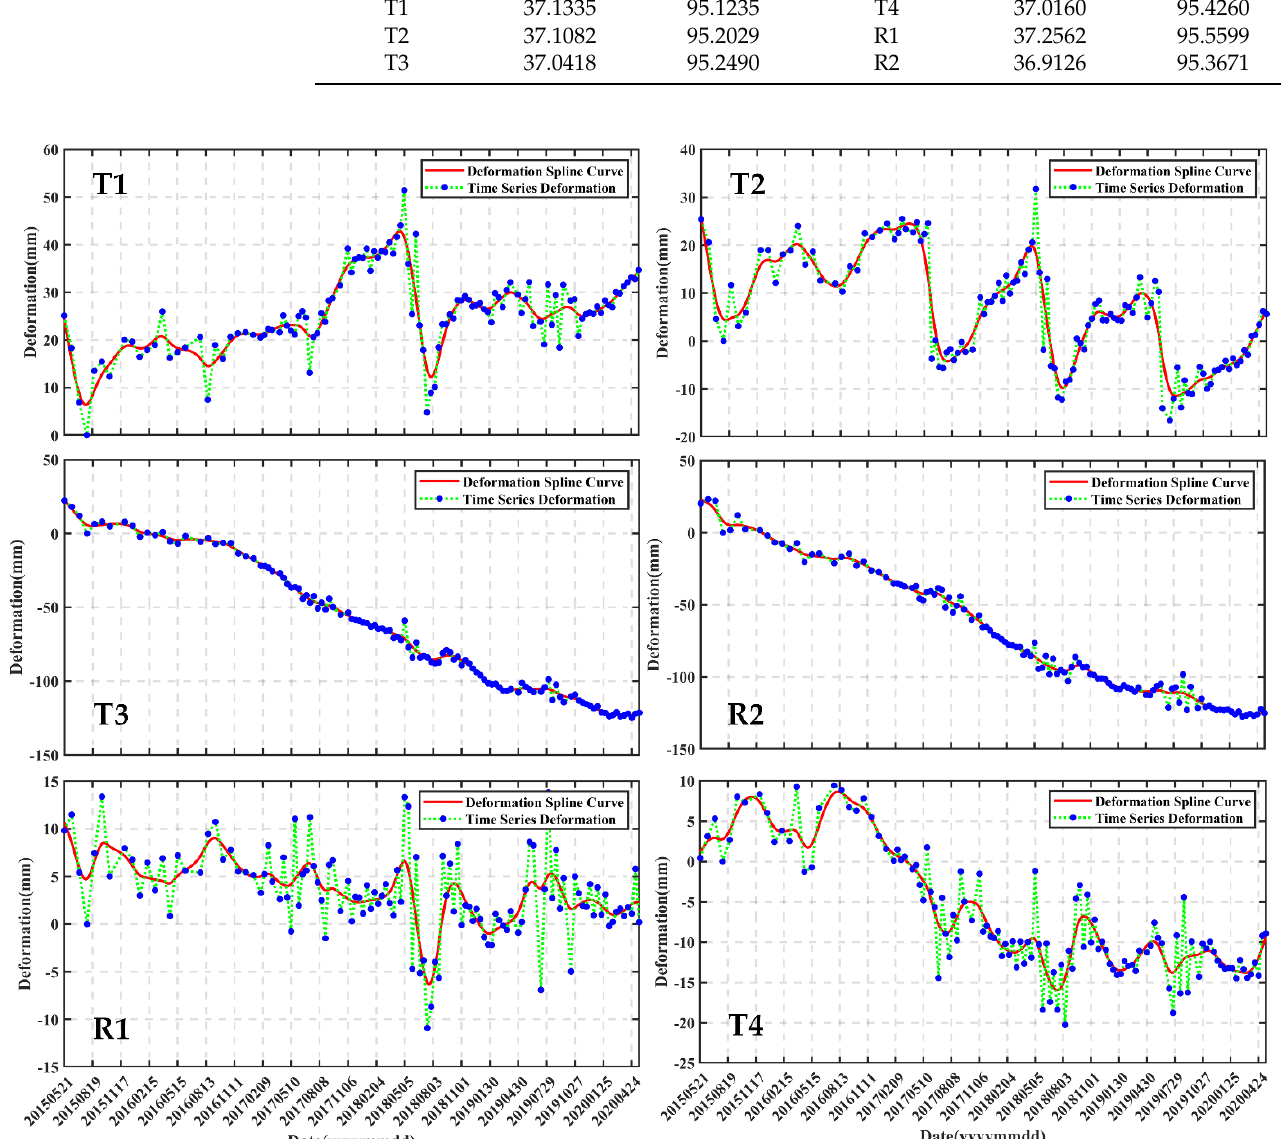
Figure 14. The time-series deformation of the representative CTs, the blue dots are the estimated results of the time-series deformation and the red line indicates the fitting result of the deformation spline curve.